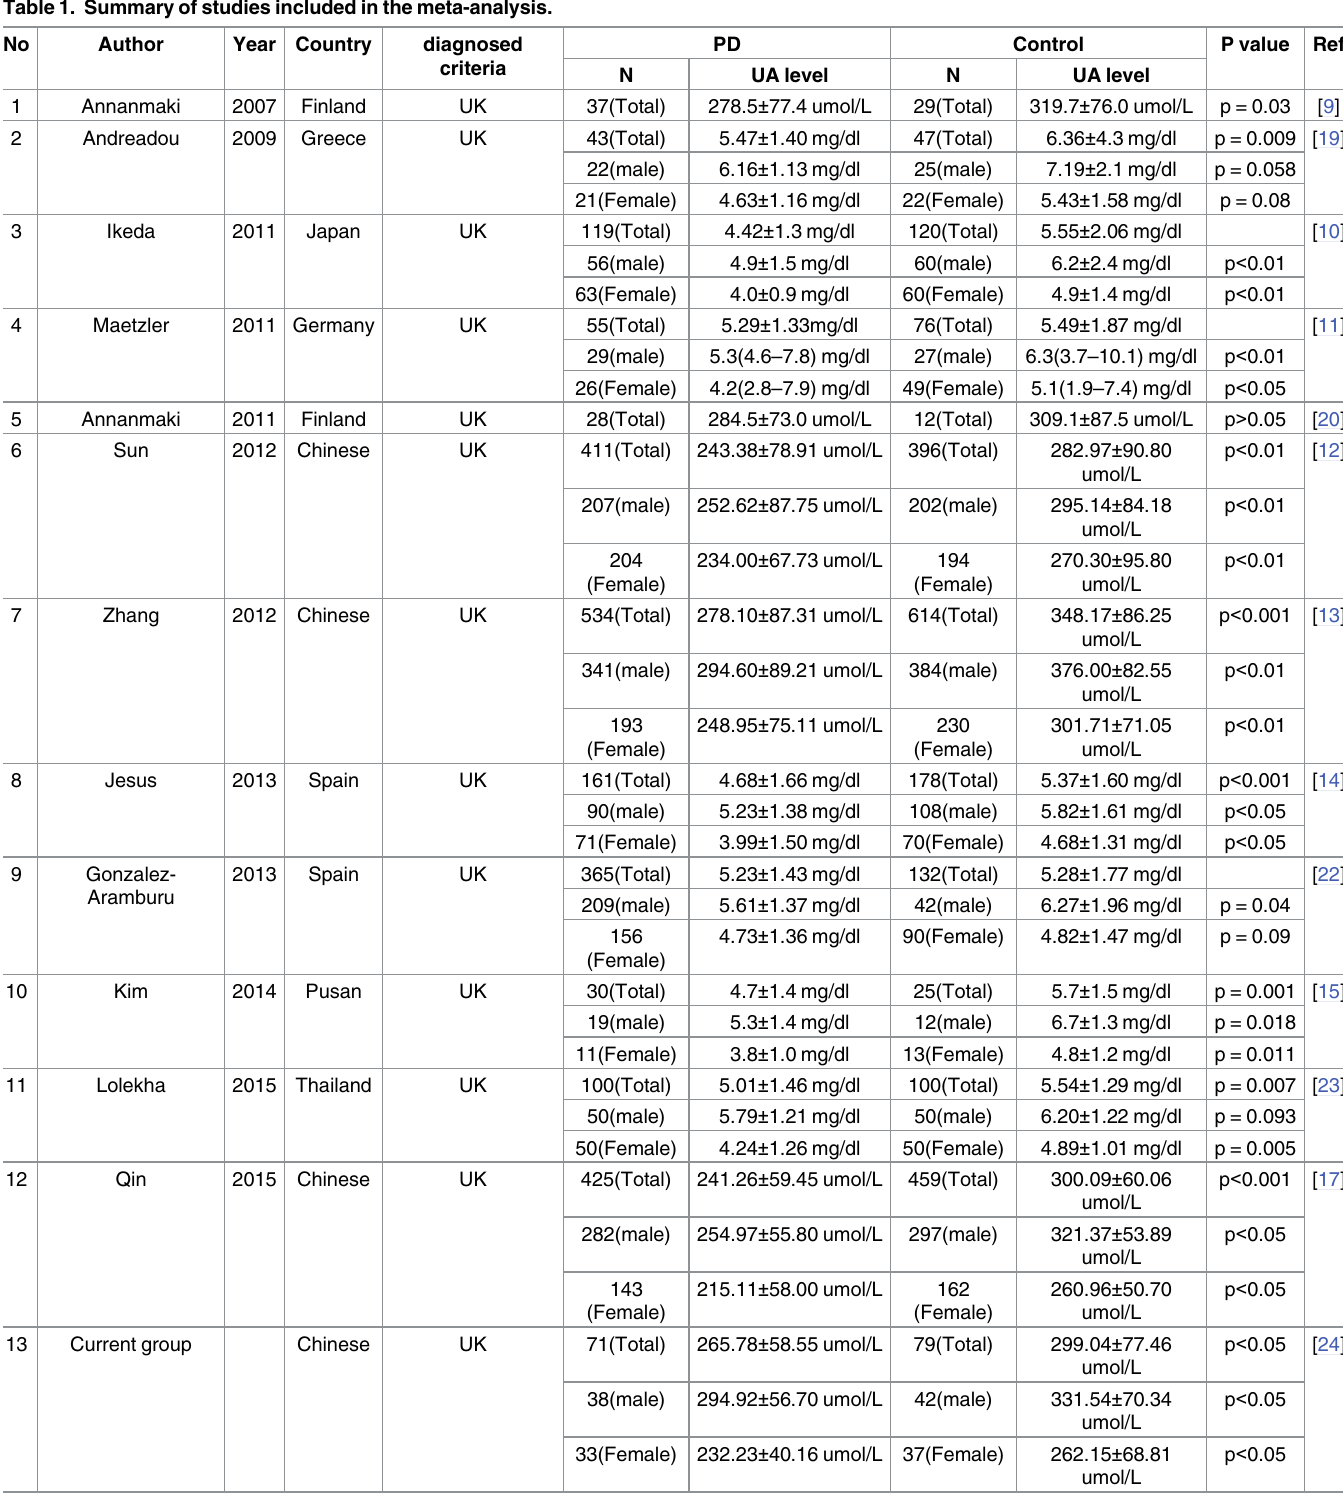
Table 1. Summaryof studies included in the